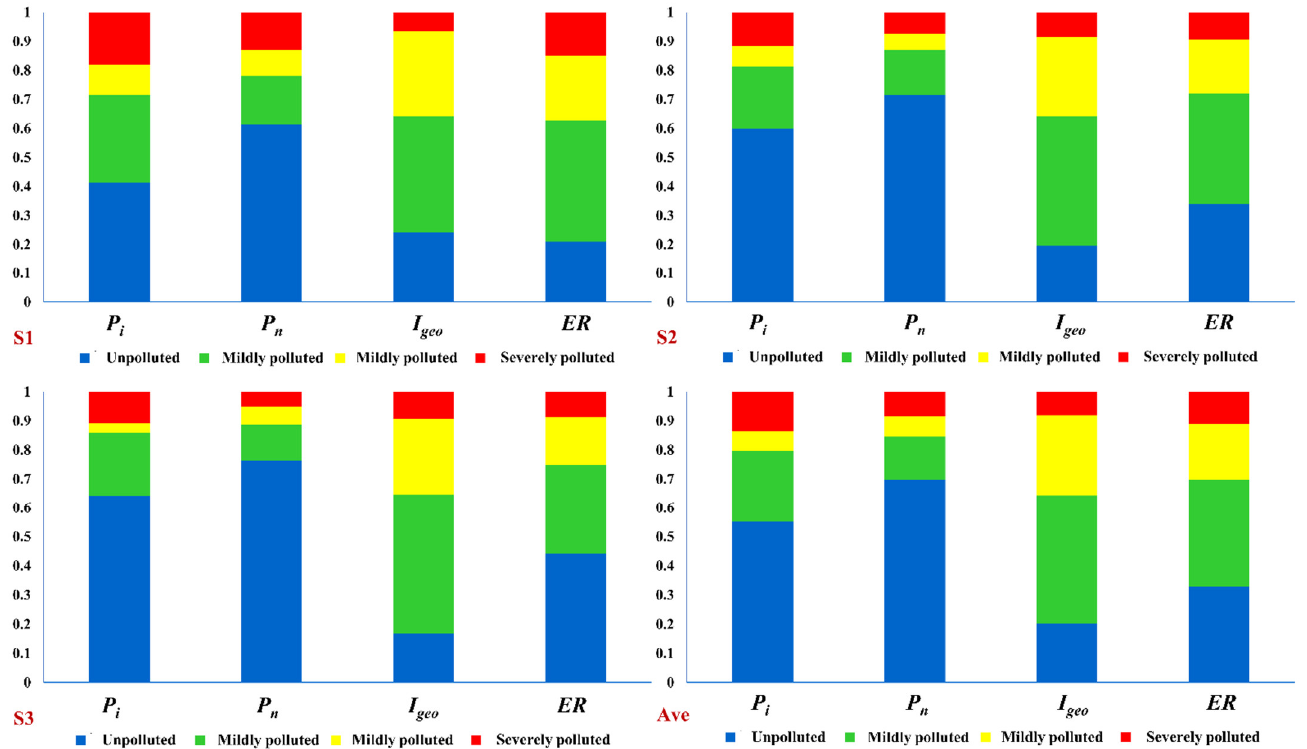
Figure 7. Comparison of the results of several evaluation indices (S1, S2, and S3, Ave represent 0–10 cm, 10–30 cm, and 30–50 cm soil layers and the mean values of the three soil layers, respectively).